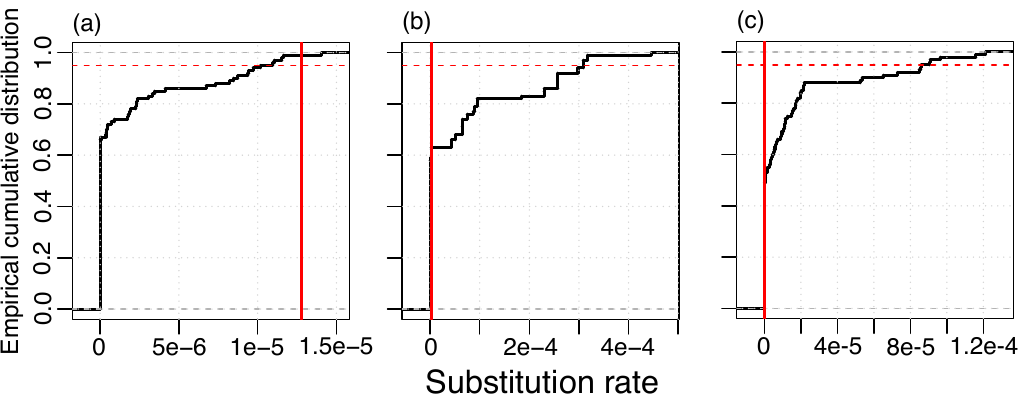
Figure 1. Resampling test for temporal signal of substitution in the masked alignment; ( a ) RIM8, 1.275 × 10 − 5 substitutions / site / year; ( b ) RIM12_C, 2.070 × 10 − 6 substitutions / site / year; and ( c ) RIM44, 10 − 10 substitutions / site / year. Vertical red line: Estimate of the real data set. 95% of the resampled data sets lie below the red dashed line.